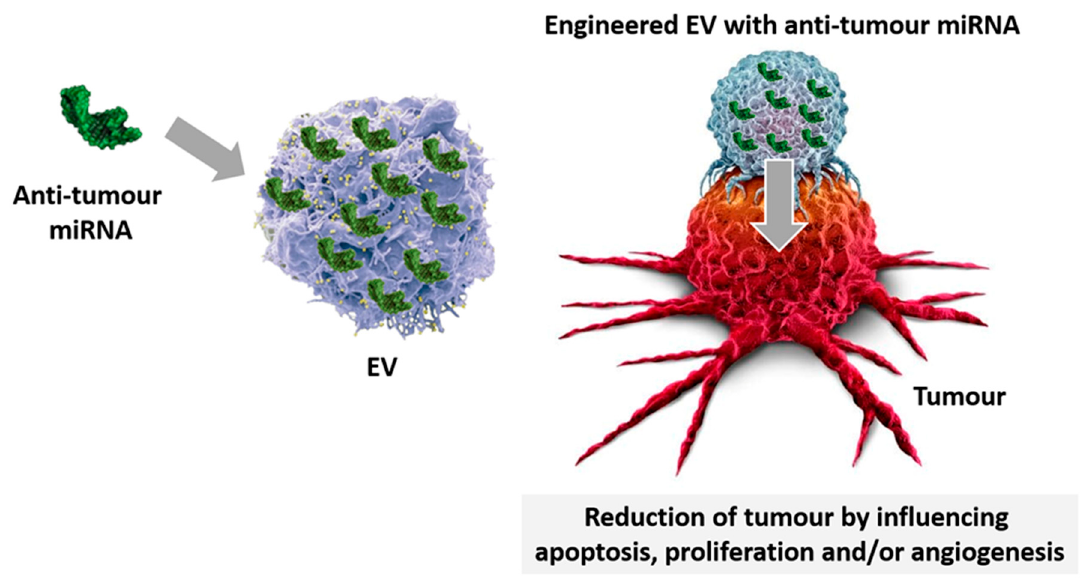
Figure 3. EV-miRNA-loading. Specific miRNA displaying anti-cancer properties are loaded in EV and used for treatment. Engineered miRNA-EV despatch their anti-tumour effects by regulating apoptosis, proliferation, and